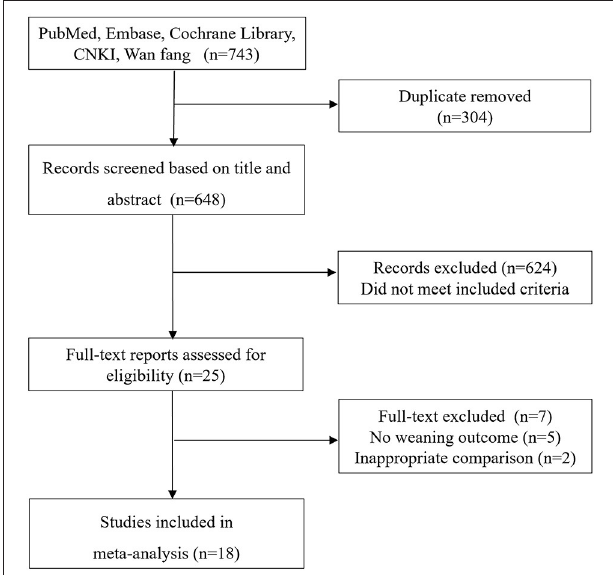
FIGURE 1 | Selection process for studies included in the meta-analysis.